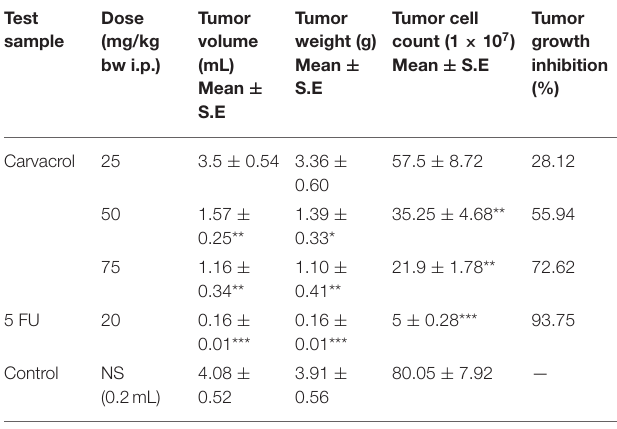
TABLE 4 | In vivo activity of carvacrol against Sarcoma-180 model. Test sample